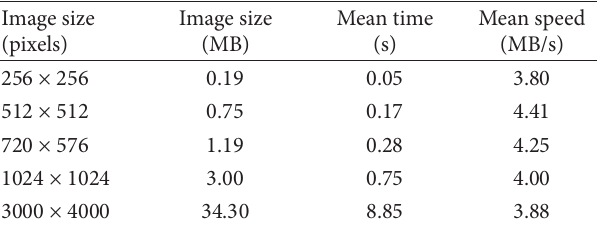
Table 3: Speed performance of the proposed cryptosystem (encryp- tion/decryption).